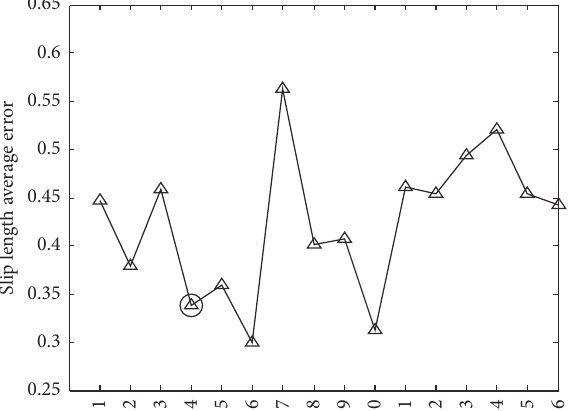
Figure 16: Relative errors of slip length under 16 situations.